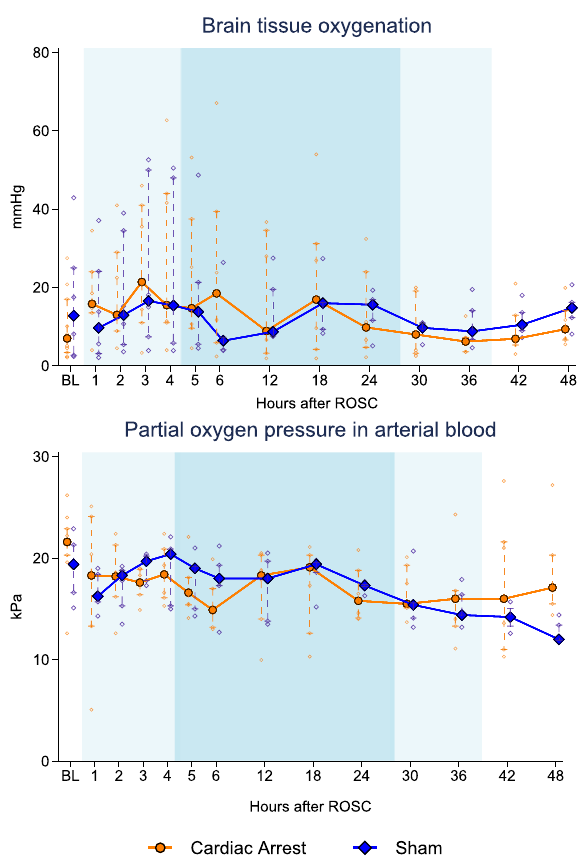
Fig. 2 Brain oxygenation and partial pressure of O 2 in arterial blood in the cardiac arrest and sham groups. Data are presented as median [25%;75%] with overlaid scatter representing each animal. Lighter blue shading indicates induction/rewarming phase, respectively, while darker blue shading indicates maintenance phase of targeted temperature management. * p < 0.01 between groups at 48 h. BL baseline before induction of myocardial infarction and cardiac